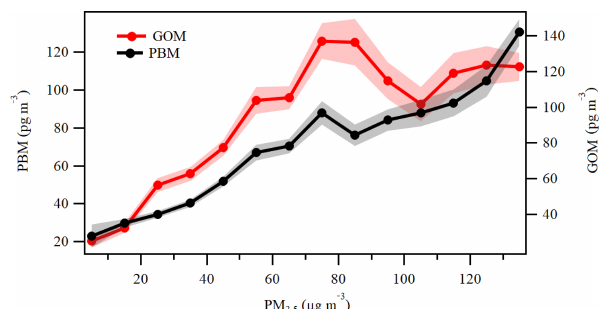
Figure 13. The variations in PBM and GOM as a function of PM 2 . 5 in each bin of 10µgm − 3 . The shaded areas represent 1 standard error of GOM and PBM